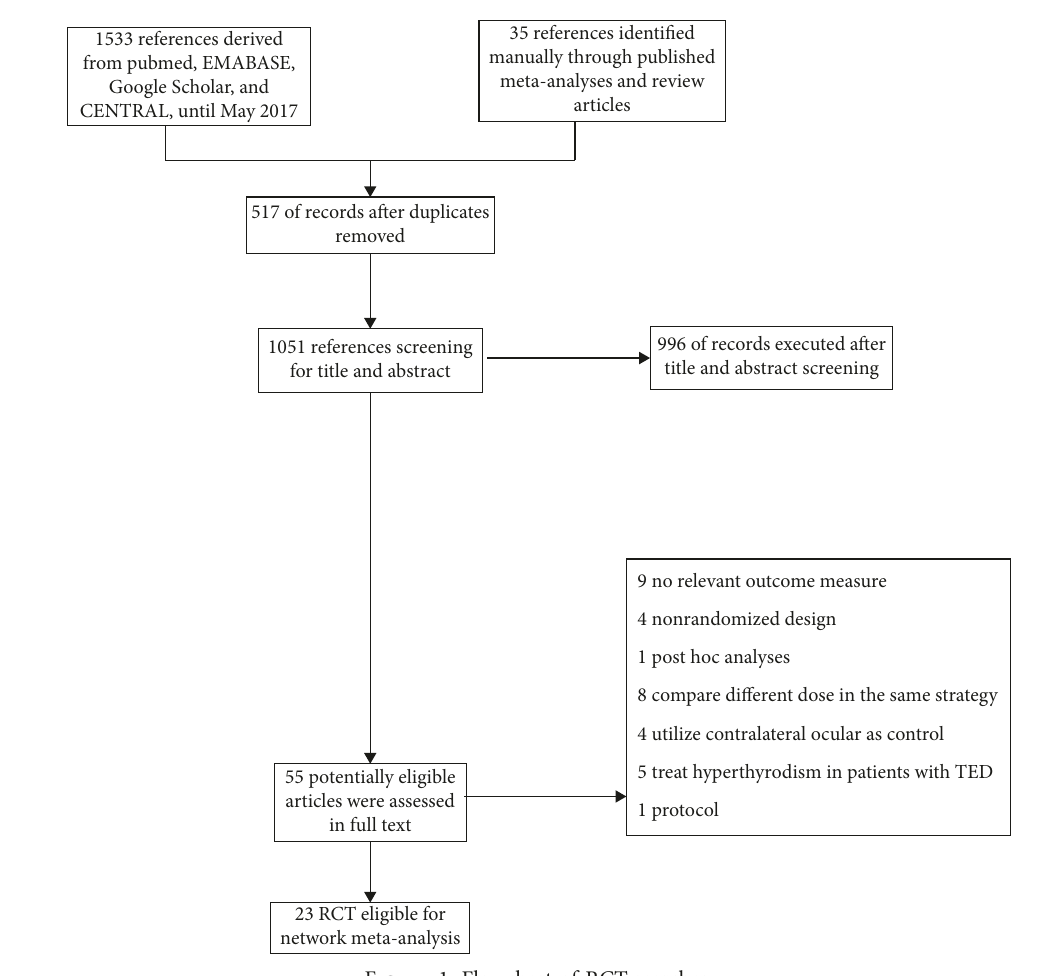
Figure 1: Flowchart of RCT searches. Table 1: Study characteristics of included